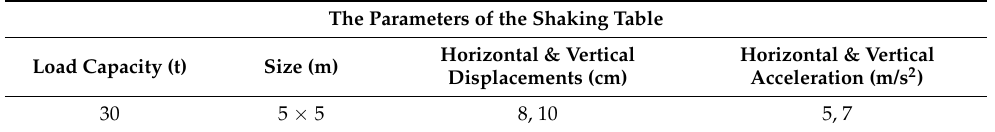
Table 4. The parameters of the shaking table and the seismic inputs. The Parameters of the Shaking Table